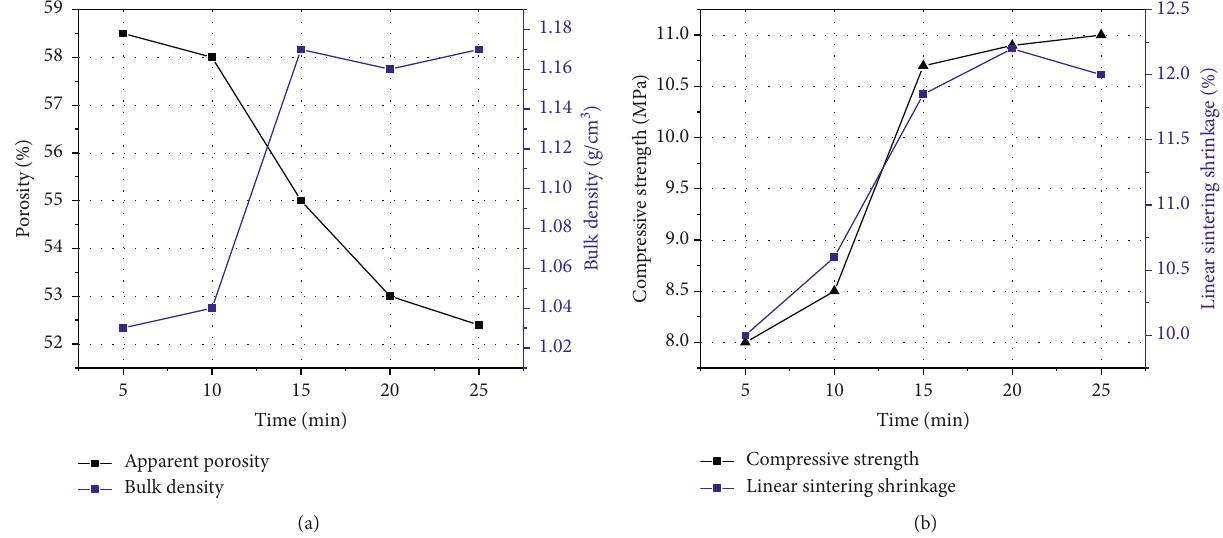
Figure 9: The influence of the holding time on (a) the apparent porosity and bulk density and (b) compressive strength and linear sintering shrinkage of as-sintered ceramics for the second-stage sintering